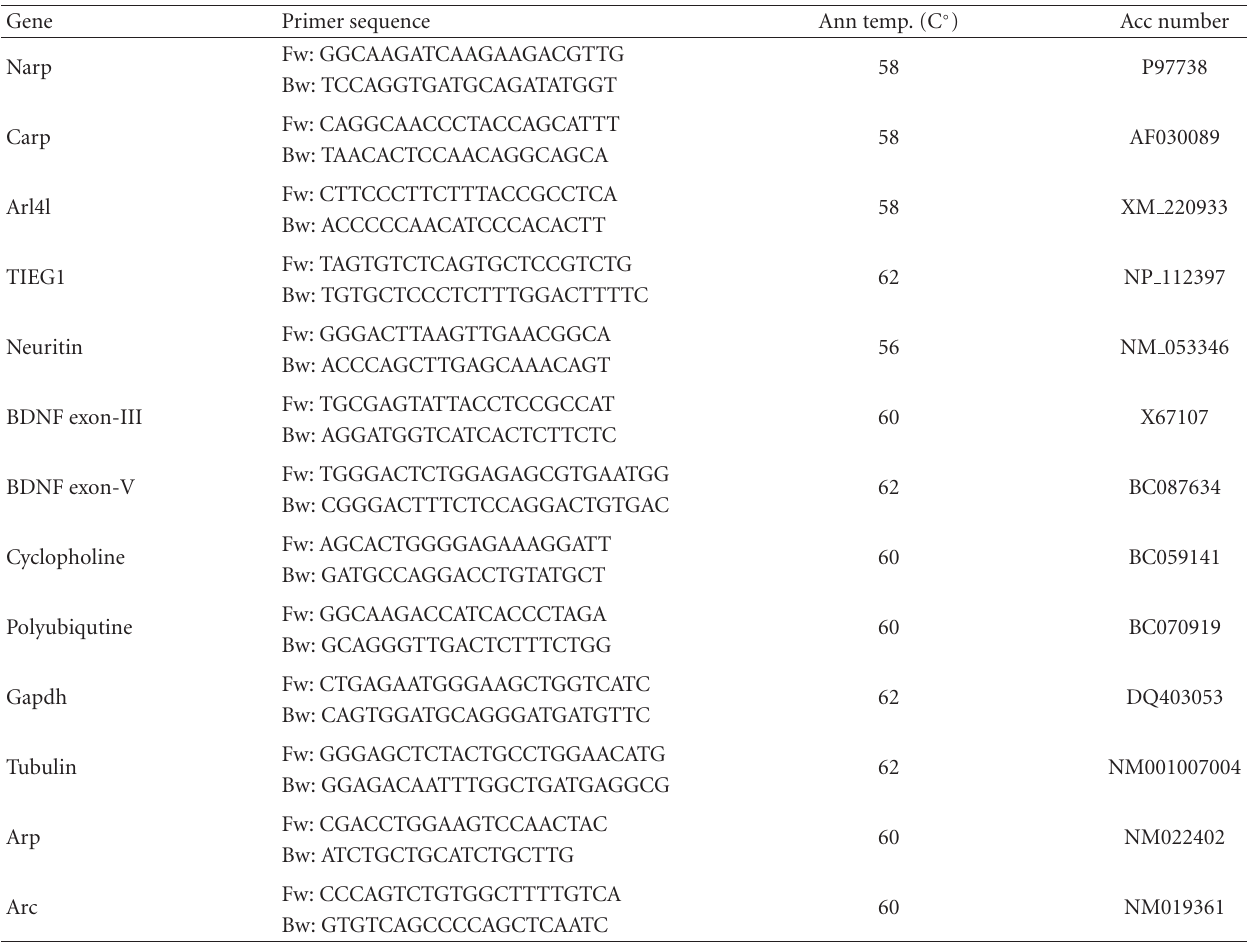
Table 1: Primer sequences, annealing temperature, and accession numbers for the analyzed